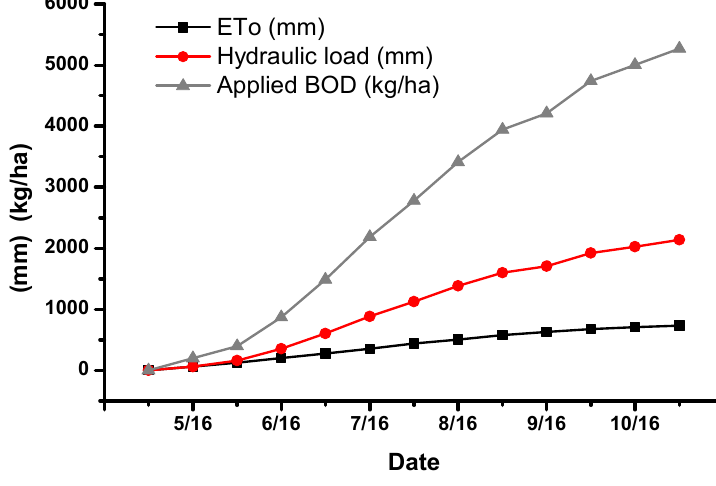
Figure 1. Cumulative reference evapotranspiration (ETo) and hydraulic and BOD 5 loading of experimental pots throughout the study